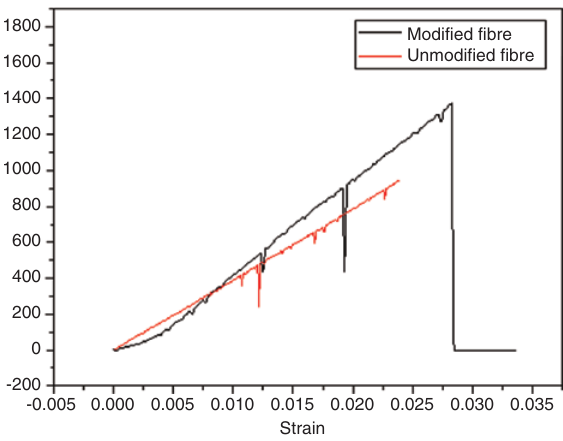
Figure 12: Tan δ curves of FCuNPs modified flax FRP composites.